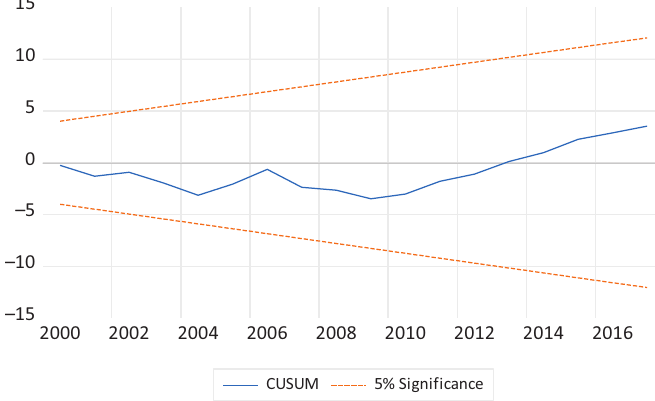
Figure 2. Plot of cumulative sum of square of recursive residual